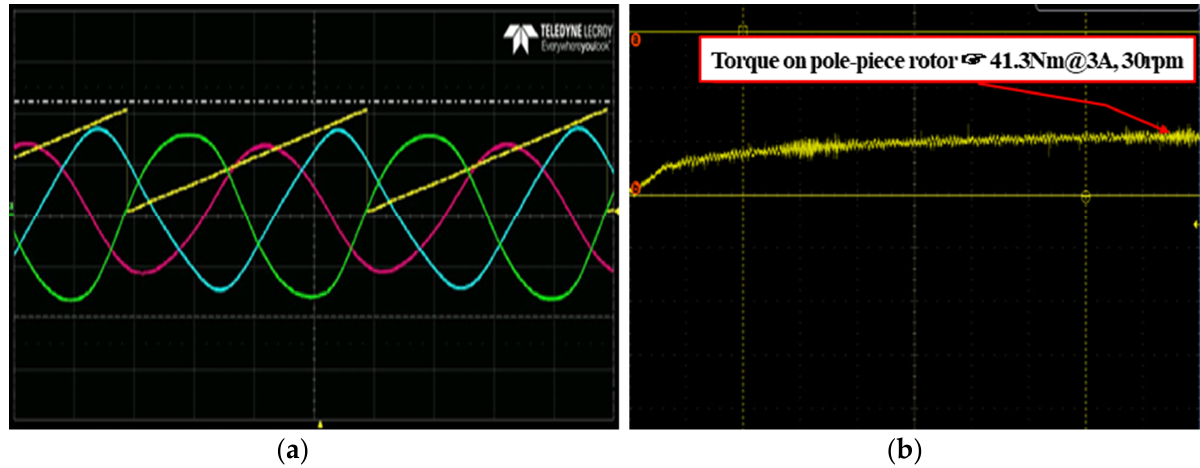
Figure 17. Measurement result by load performance test of 4.5kW-class MG-PMSM prototype (pole piece/PM rotor@30/21 rpm): ( a ) Phase of 3-phase current (6.5 Hz, 3 A); ( b ) Torque on the pole piece rotor.